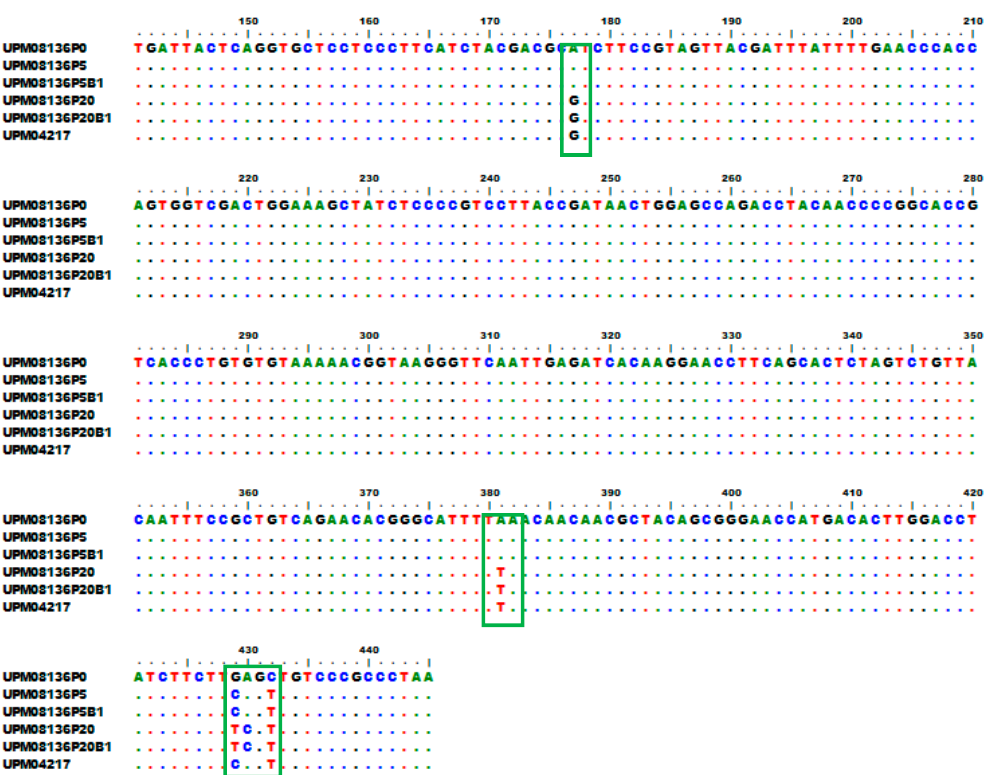
Figure 7. Multisequence alignment comparing the nucleotide sequences of fiber gene of the original, flask and bioreactor propagated isolates of UPM08136 and UPM04217 reference isolate from Genebank. There were no changes between the flask and bioreactor isolates observed in the fiber gene of the test FAdV strains. The changes in the CEL passages (green boxes) remained the same.